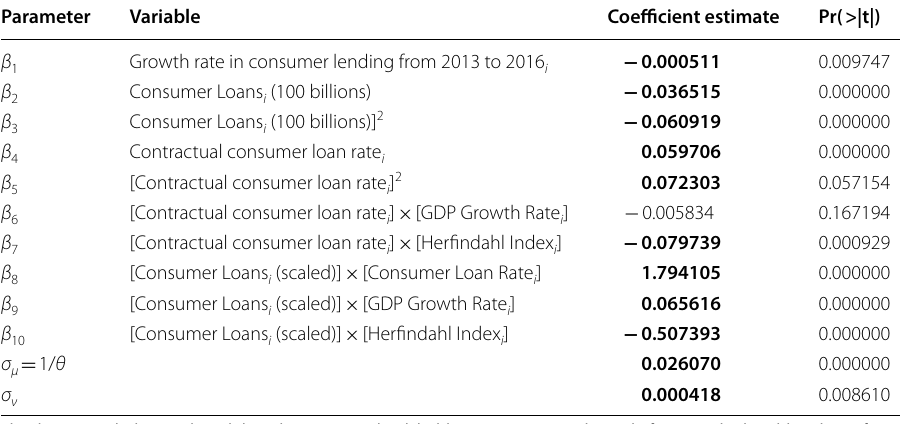
Table 1 2016 Unsecured consumer loans–stochastic frontier estimation. Including the volume of unsecured consumer lending. Best‑practice (minimum) ratio of nonperforming consumer loans